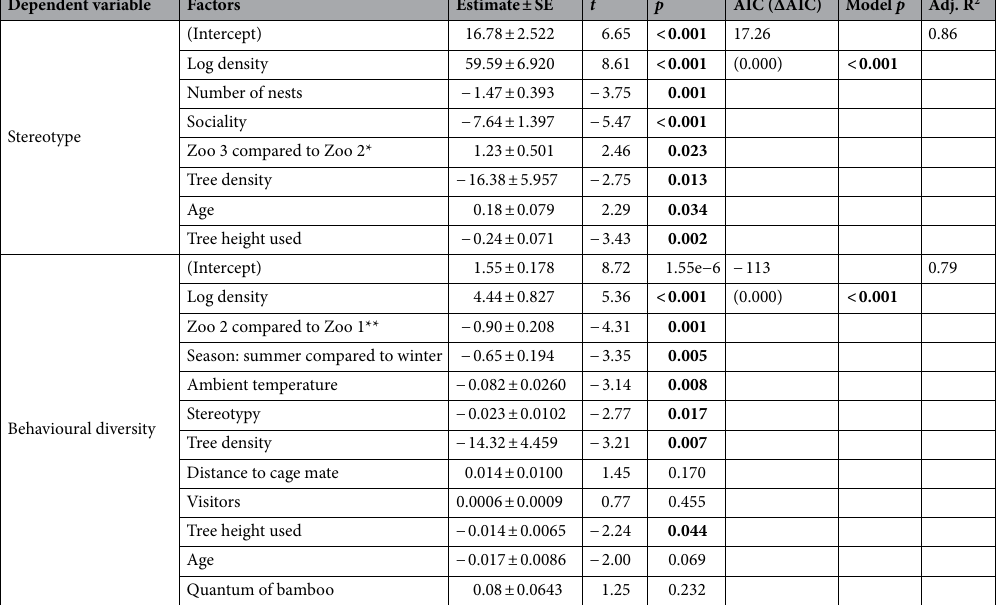
Table 2. REVS model to explore the effect of biological and environmental factors on the intensity of stereotype and level of behavioural diversity among captive pandas in India zoos. Significant values are in bold. *Zoo 1 kept as reference category. **Zoo 3 kept as reference